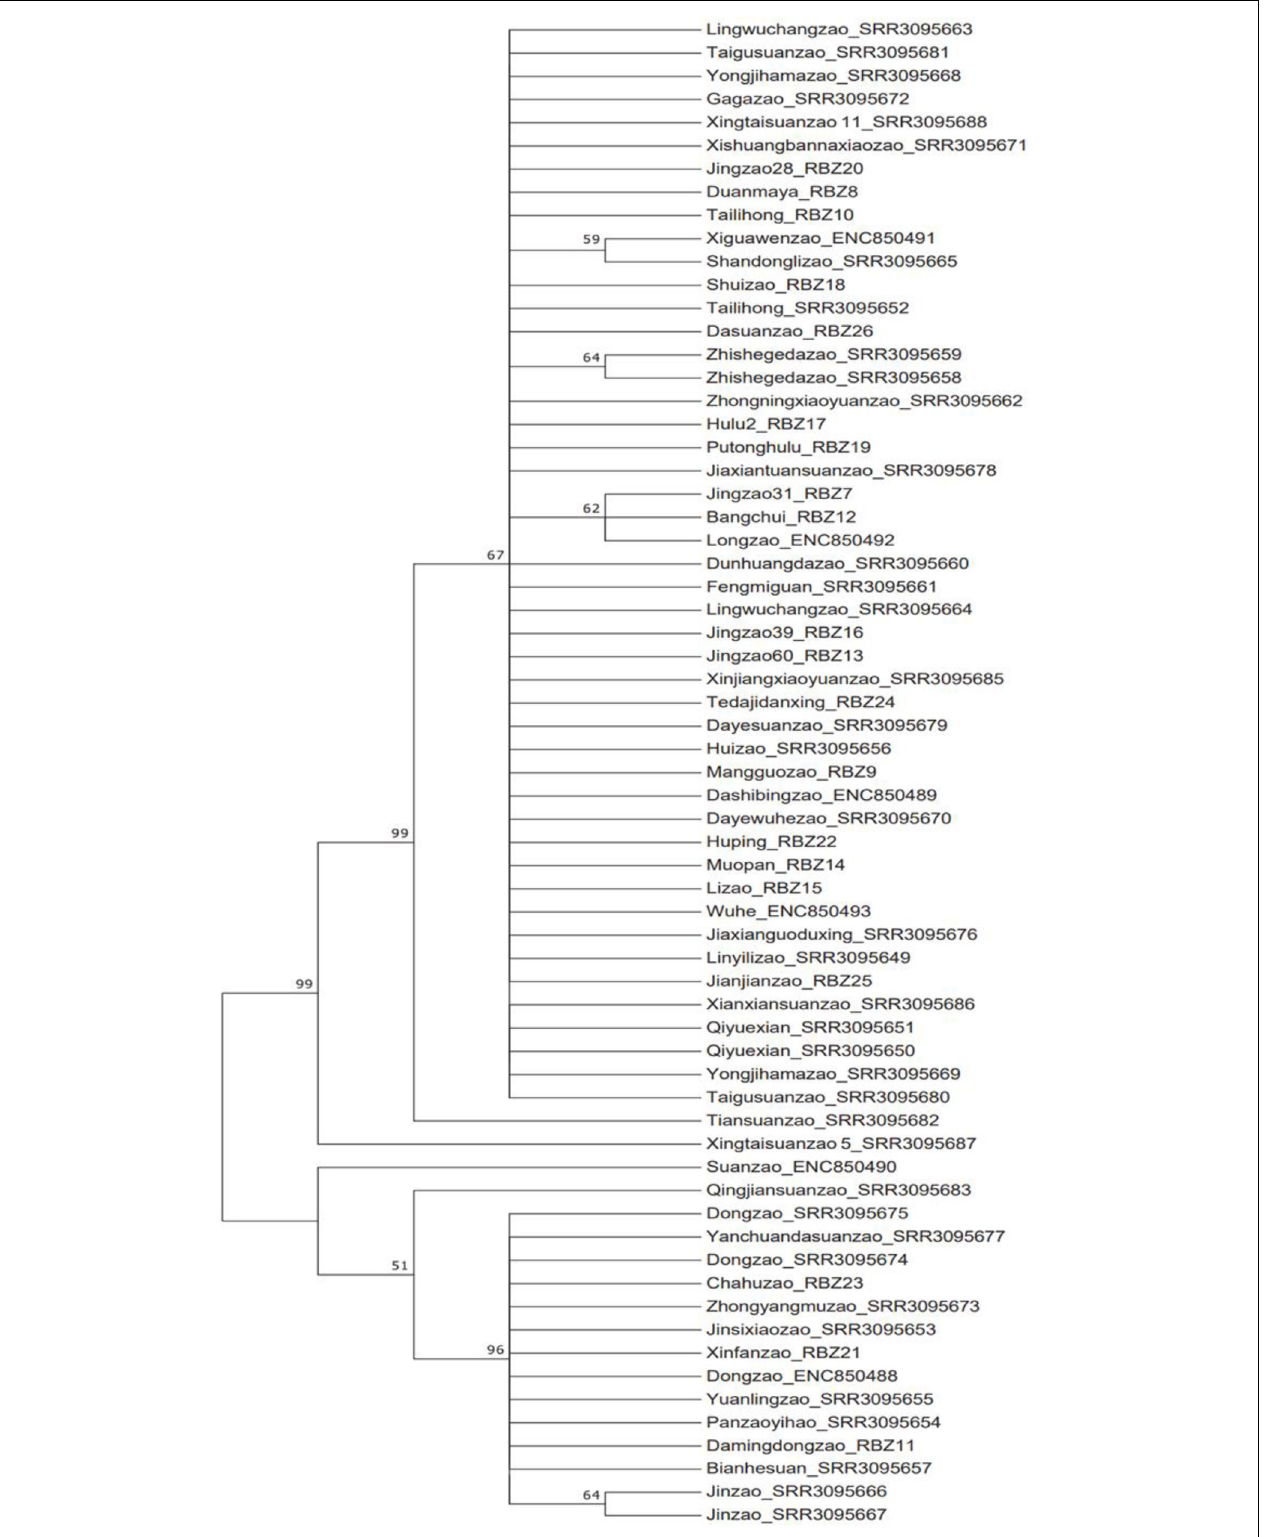
FIGURE 5 | Phylogenetic tree of 65 jujube plastomes based on whole chloroplast genome sequences with maximum likelihood and Bayesian inference. Numbers near the nodes are values for bootstrap support.